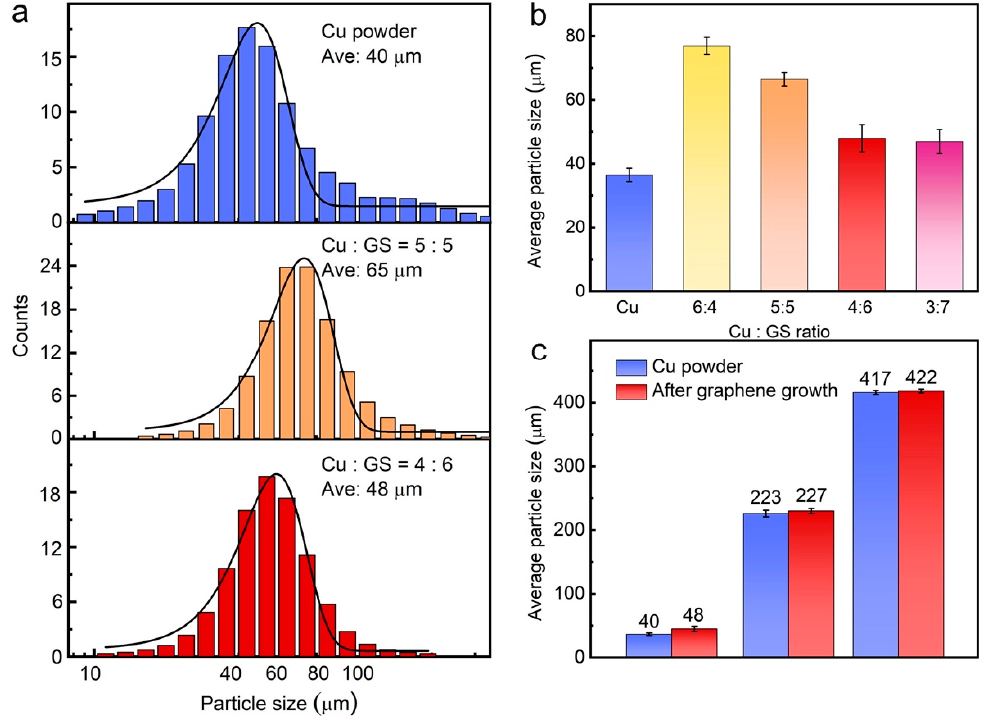
Figure 3. ( a ) The comparison of the size distribution between Cu powder and Gr/Cu microparticles; ( b ) change of the average size of Gr/Cu microparticles prepared with various mixing Cu: GS ratios; ( c ) from Cu powder with three different sizes.